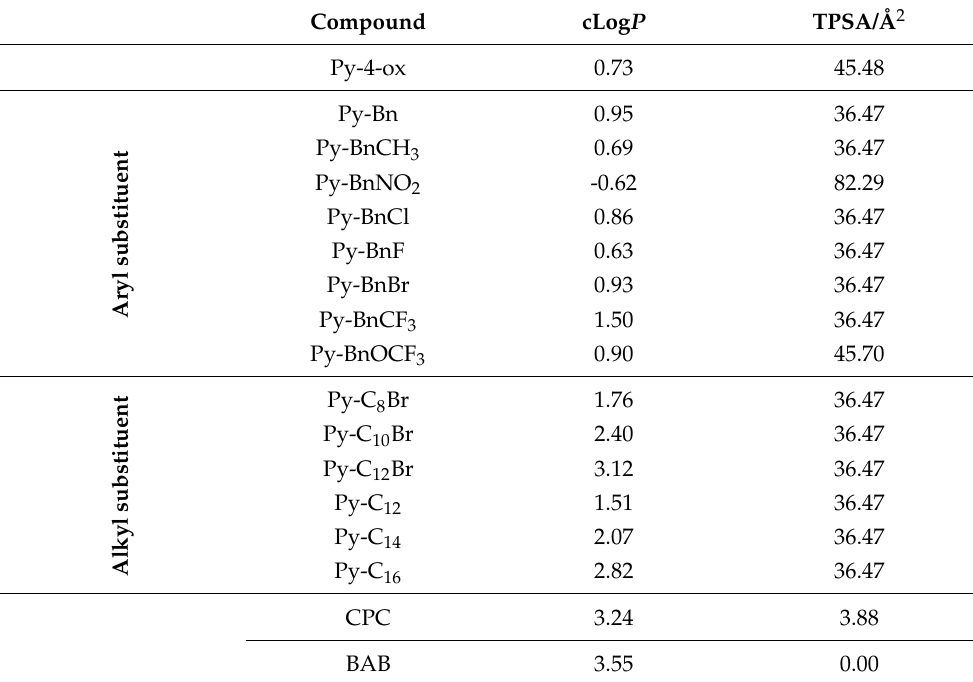
Table 3. Consensus partition coefficients (cLogP) and topological polar surface area (TPSA/Å 2 ) of